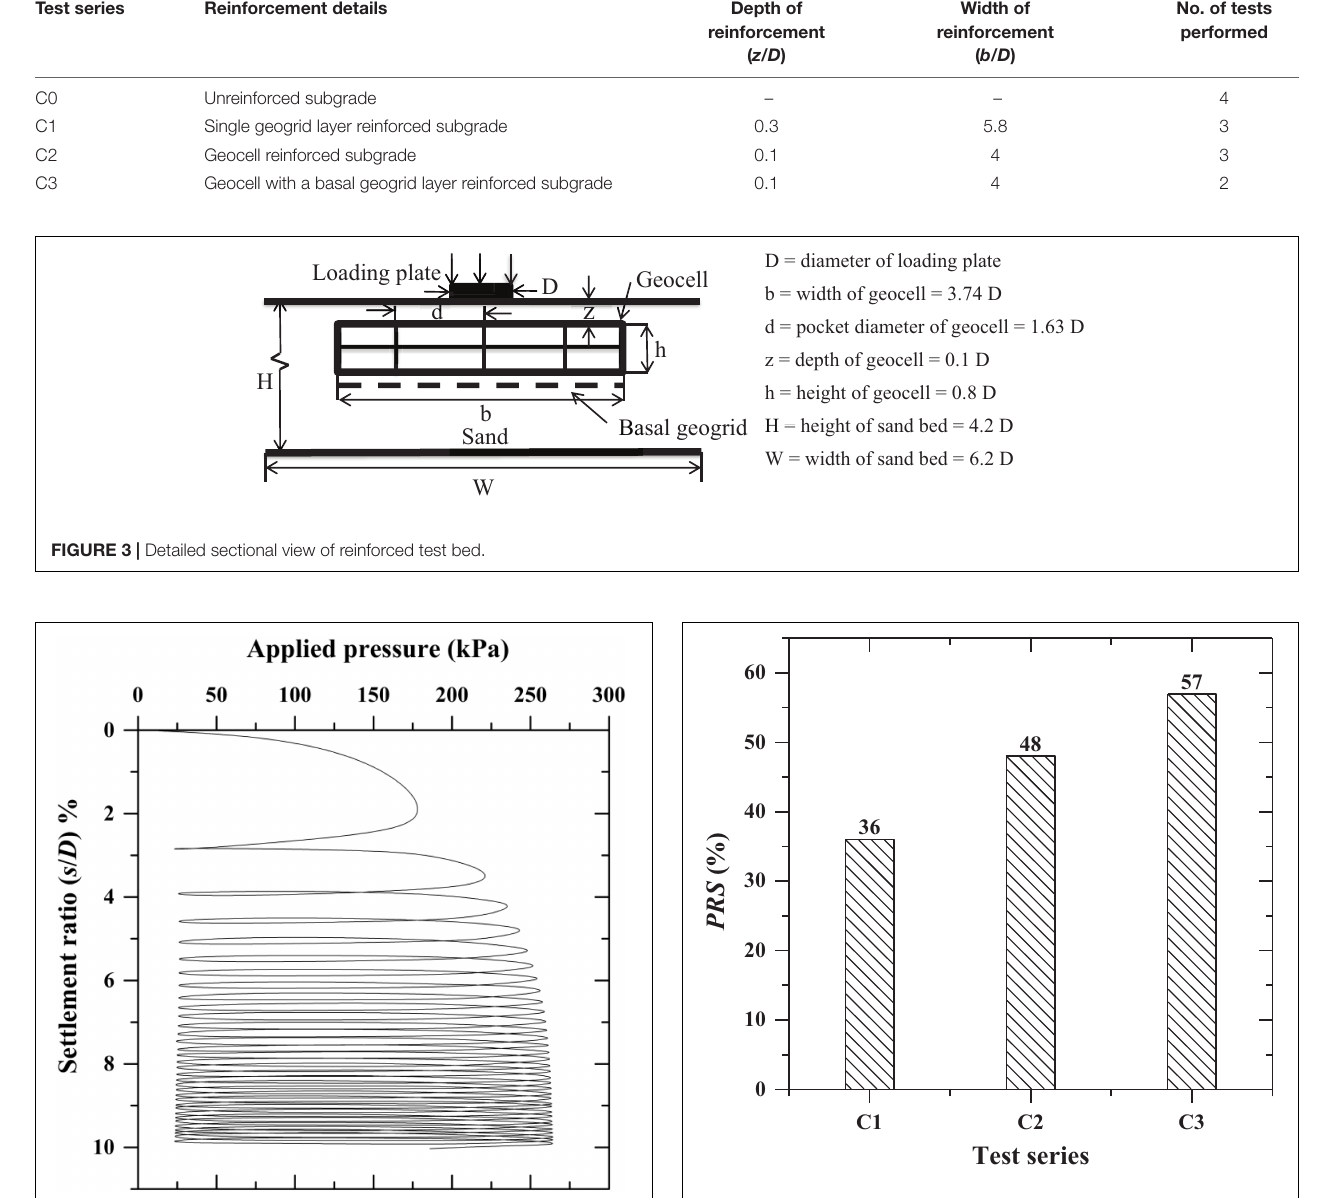
FIGURE 4 | Typical variation of settlement ratio with applied pressure.